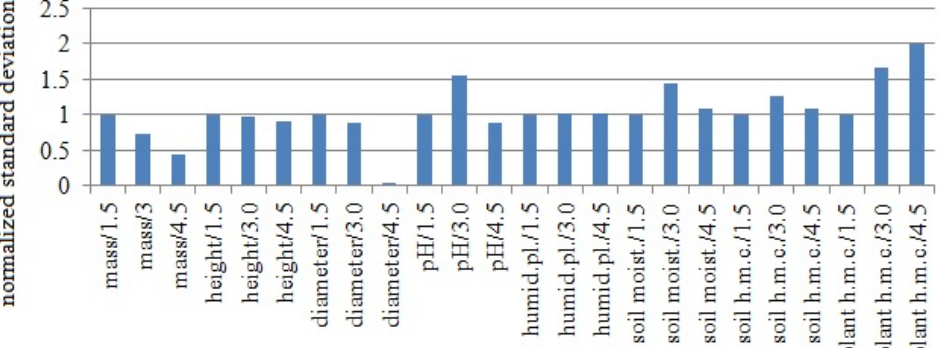
Figure 4. Variation of eight parameters of the plant after contaminating the soil, using the normalized standard deviation, in consideration of Zn accumulation (where humid.pl.: plant water content; soil moist.: soil moisture; soil h.m.c.: soil heavy metal concentration; plant h.m.c.: plant heavy metal concentration).